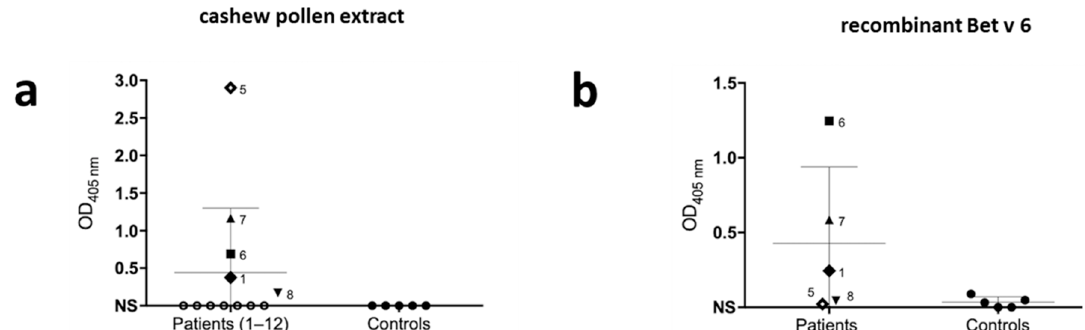
Figure 4. Cashew tree pollen and recombinant birch isoflavone-reductase (Bet v 6) are recognized by patients’ sera in ELISA. ( a ) IgE reactivity to immobilized cashew tree pollen extract was assessed with individual patients’ sera ( n = 12) and non-atopic human sera ( n = 5). ( b ) IgE reactivity to immobilized recombinant Bet v 6 was assessed with patients’ sera that were positive in ELISA for cashew tree pollen extract ( n = 5) and non-atopic human sera ( n = 5). The NS indicates the response threshold calculated as 3 × SD of the buffer control signal.